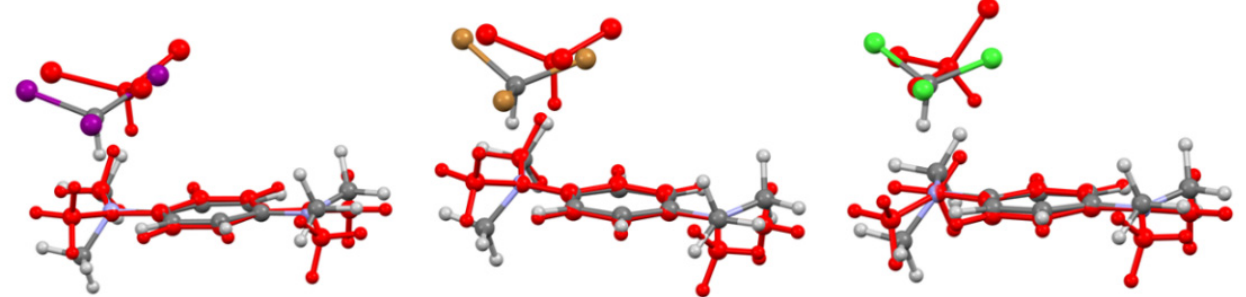
Figure 8. Structural overlap of the associations between TMPD and CHI 3 ( left ), CHBr 3 ( middle ) and CHCl 3 ( right ) formed via H–N bonding and alternative complexes (shown as red structures).